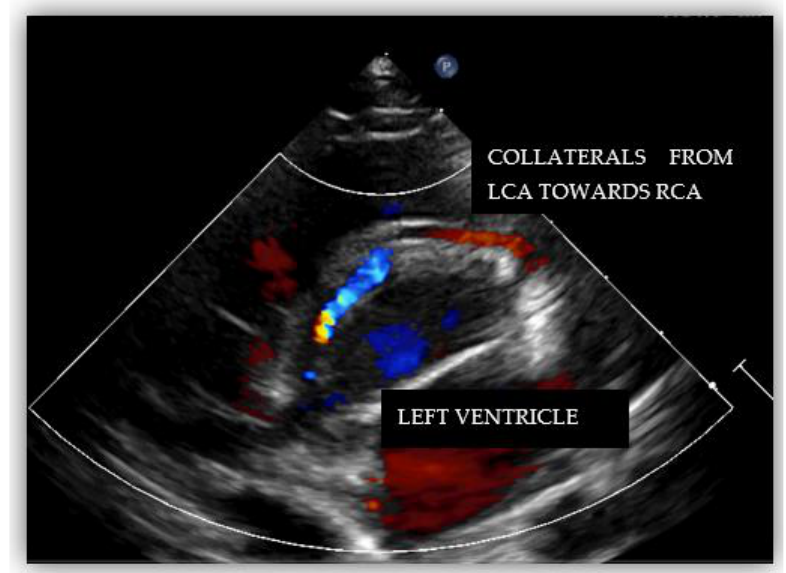
Figure 3. Echocardiography in parasternal short-axis showing collateral circulation.